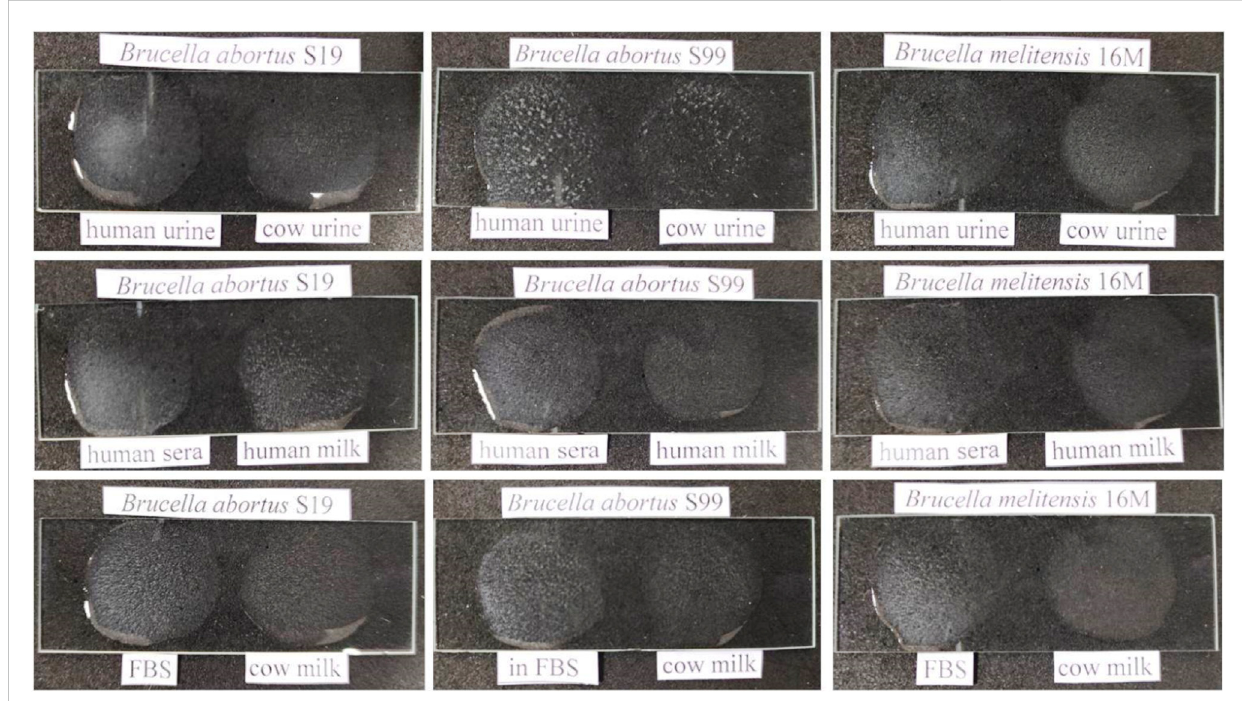
FIGURE 13 Evaluation of experimental validation for rapid and direct-differential slide agglutination assay with spiked WC Ags of Brucella standard strains ( Brucella abortus S19, Brucella abortus S99, and Brucella melitensis 16M) in different clinical (cow and human urine, FBS-fetal bovine sera, and human sera) and non-clinical (cow and human milk) matrices at an obtained experimental LOD of 10 4 CFU mL − 1 . A clear, rapid, and strong positive agglutination reaction appeared initially in spiked sera samples, followed by milk and urine samples with no relative interference of test